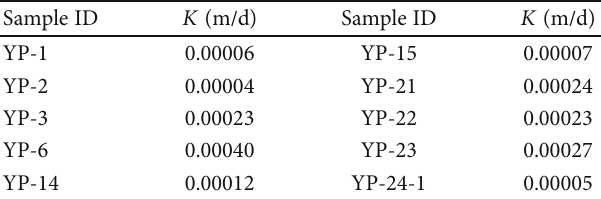
Table 4: The hydraulic conductivity of the stable stage. Sample